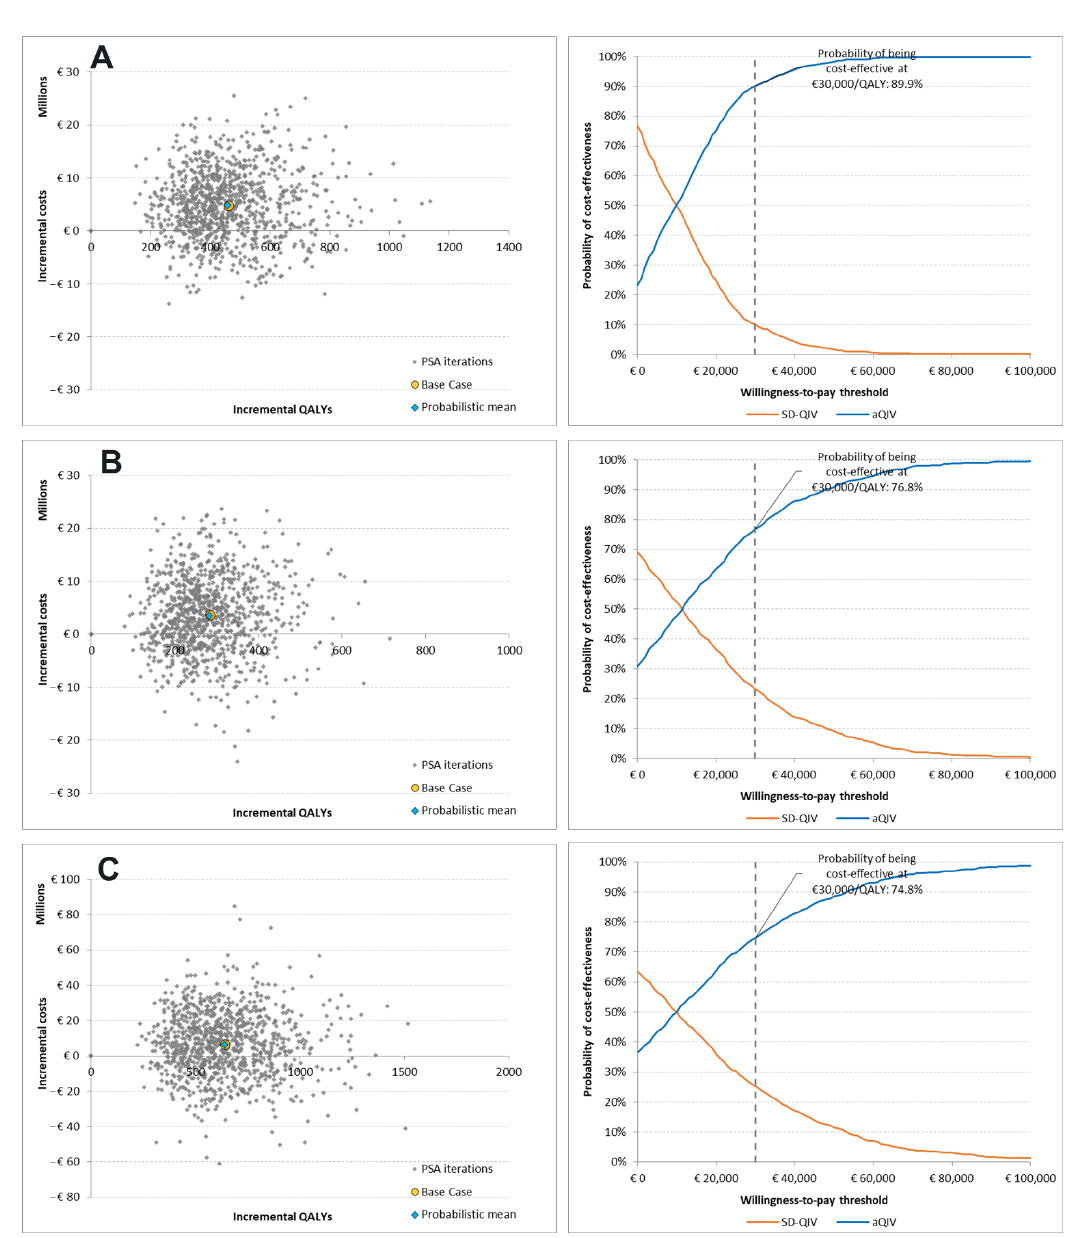
Figure 3. PSA results (aQIV vs. SD-QIV): ( A ) Denmark, ( B ) Norway, and ( C ) Sweden. From a healthcare payer perspective, the cost-effectiveness acceptability curves (CEACs) showed that aQIV was more likely to be cost-effective than SD-QIV in Denmark (90%), Norway (77%), and Sweden (75%), at a threshold of EUR 30,000/QALY. Our results showed that aQIV was a dominant strategy in 23%, 32%, and 36% of the simulations for Denmark, Norway, and Sweden, respectively.